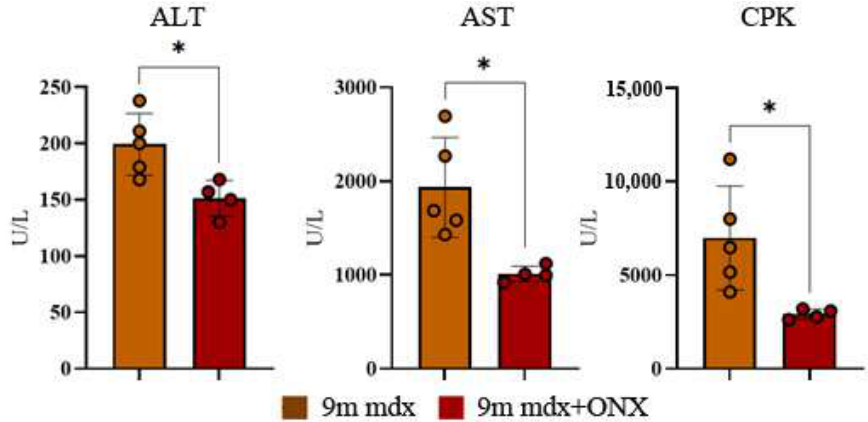
Figure 2. Serum ALT, AST and CPK levels in 9m mdx and 9m mdx+ONX mice. ALT, AST and CPK were measured in blood serum drawn from 9m mdx ( n = 5) and 9m mdx+ONX mice ( n = 4). Data are expressed as means ± SD of n = 4–5 9m mdx and 9m mdx+ONX mice (* p < 0.05, with unpaired t -test).